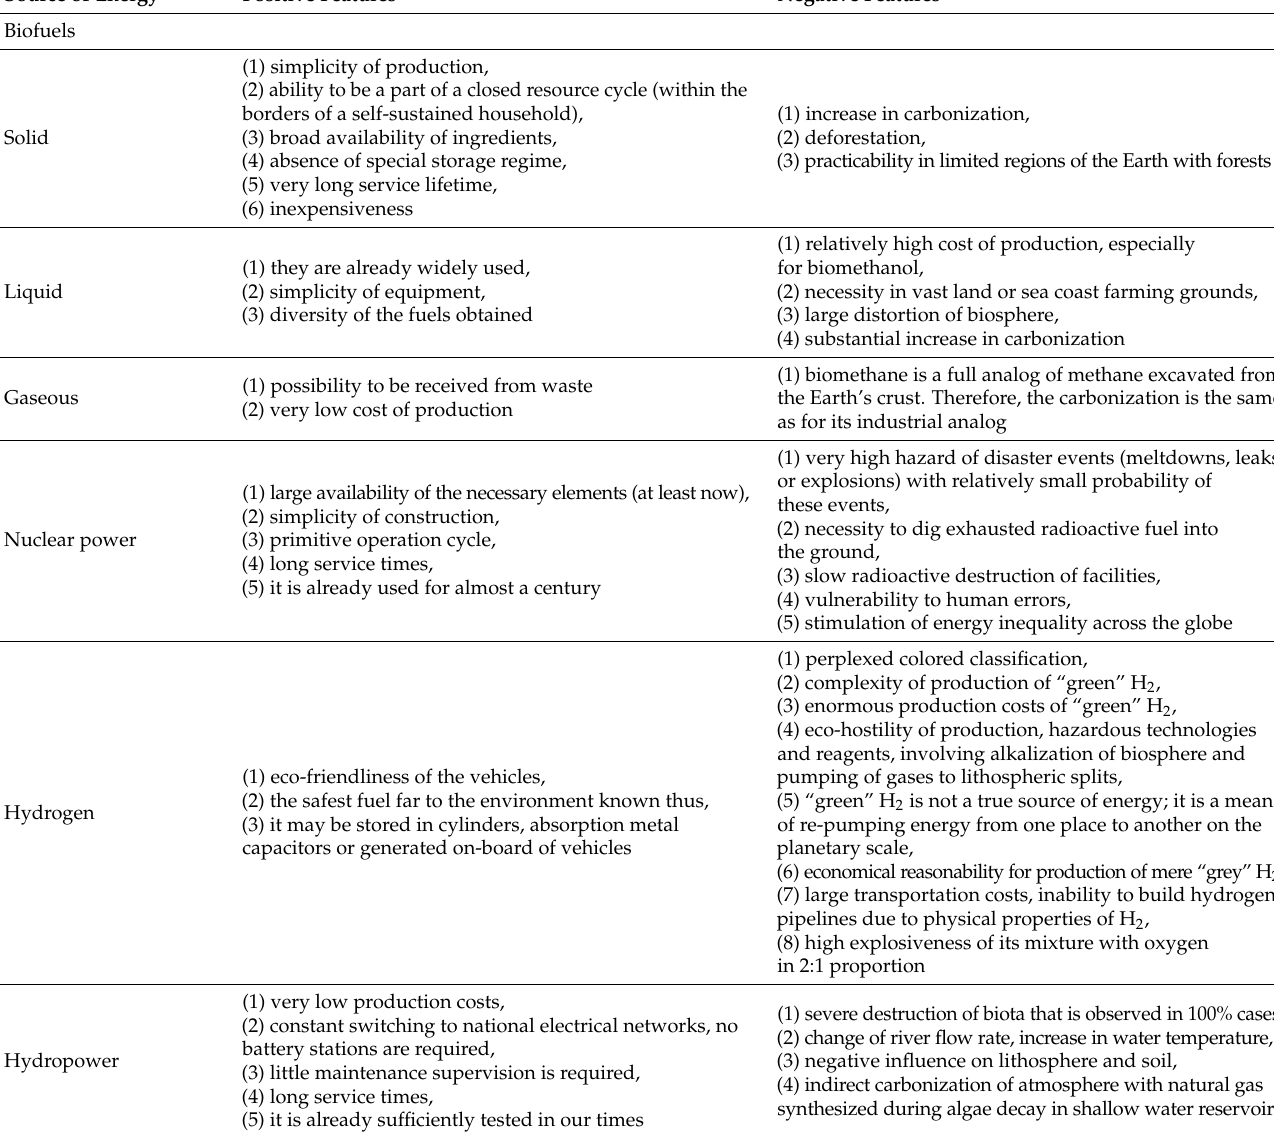
Table 1. Pros and contras of different ASE in the context of their practicability/safety within the Spaceship Earth